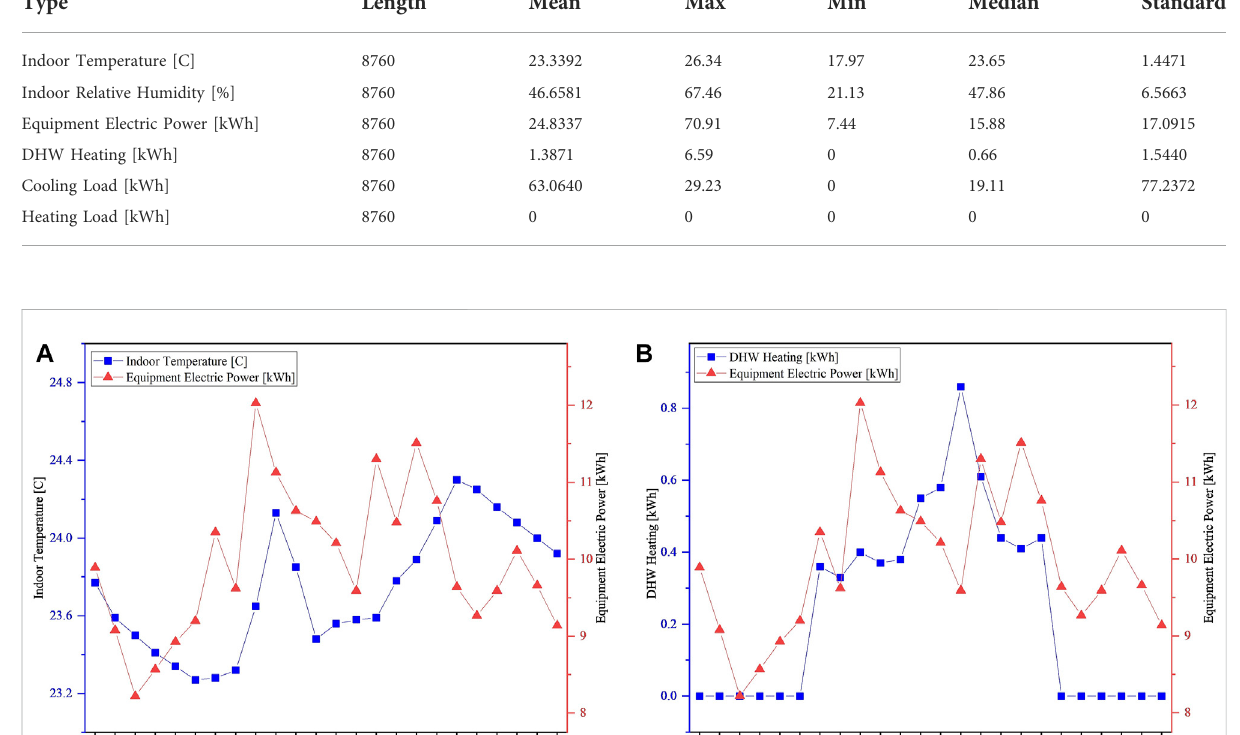
algorithm Q-learning to fi nd the optimal strategy of the best prediction model at each prediction time step.